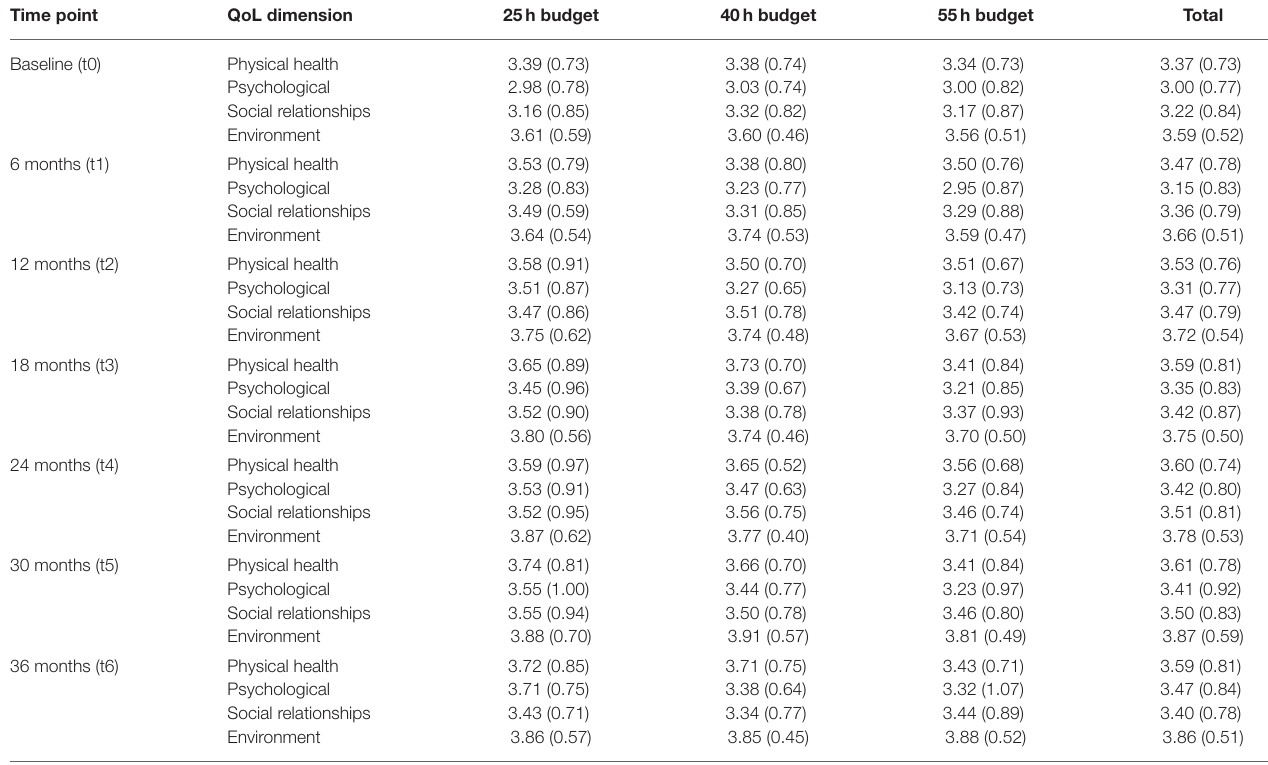
TABLE 2 | Randomly allocated placement budgets in association with repeated measures of QoL. Time